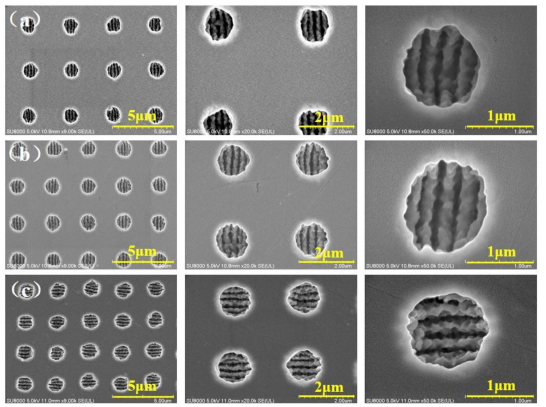
Figure 4. SEM images of microhole arrays with different periods. ( a ) 3.6 µ m period; ( b ) 3.0 µ m period; ( c ) 2.6 µ m